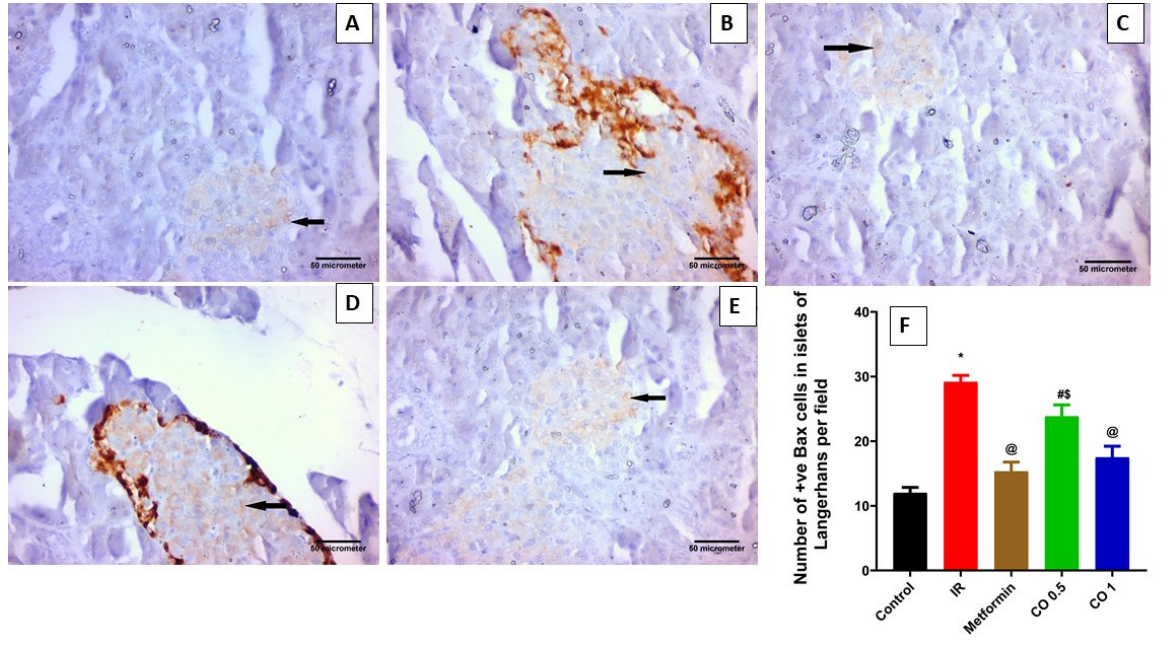
Figure 7. Effect of coriander oil and metformin (50 mg/kg/day, PO) on pancreatic apoptosis marker, BAX in dexamethasone-induced insulin resistance in rats (RI). Photomicrograph of a pancreatic sections of ( A ) the control group displaying few of the islet cells are BAX positive cells; ( B ) the IR group displaying most of the islet cells are BAX positive cells; ( C ) metformin group showing some of the islet cells are BAX positive cells; ( D ) coriander oil (low dose group, 0.5 mL/kg, PO) displaying many of the islet cells are BAX positive cells; ( E ) coriander oil (high dose group, 1 mL/kg, PO) displaying some of the islet cells are BAX positive cells (Avidine biotin peroxidase stain with Hx counter stain × 400, scale bar = 50 µ m); ( F ) Bar graph showing the difference in number of immunopositive BAX cells in islets of Langerhans per field in all studied groups which was quantified ×400. Results were analyzed by one-way ANOVA followed by the Post-hoc Tukey test. Results are shown in mean ± SEM ( n = 6). * , @, #, $ p < 0.05 compared to normal, IR, metformin, and high dose coriander oil (CO 1) groups, respectively.